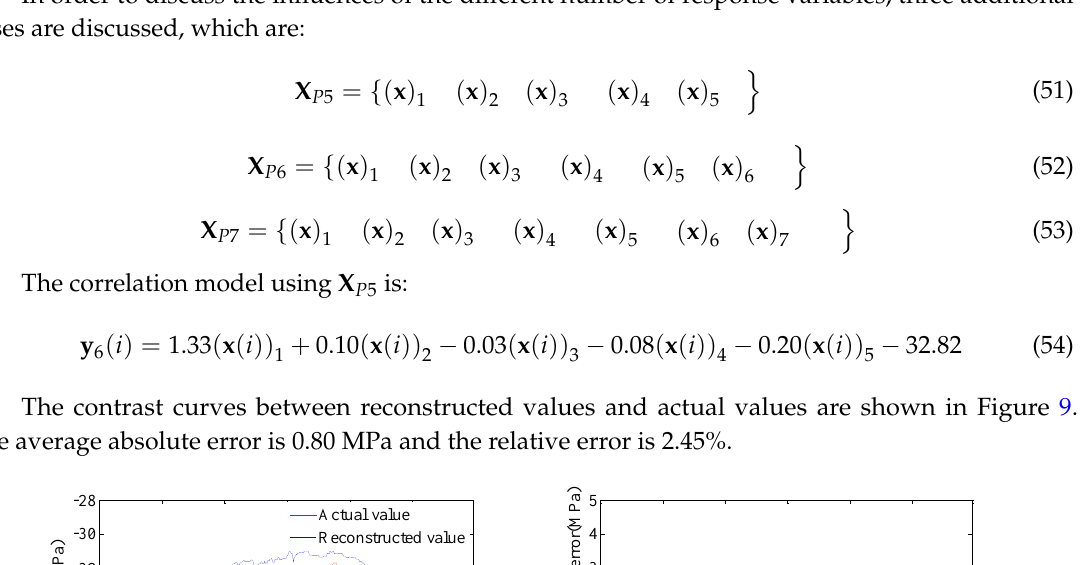
Figure 8. The reconstructed value and actual value using data from 7 May 2014 to 14 May 2014: ( a ) the